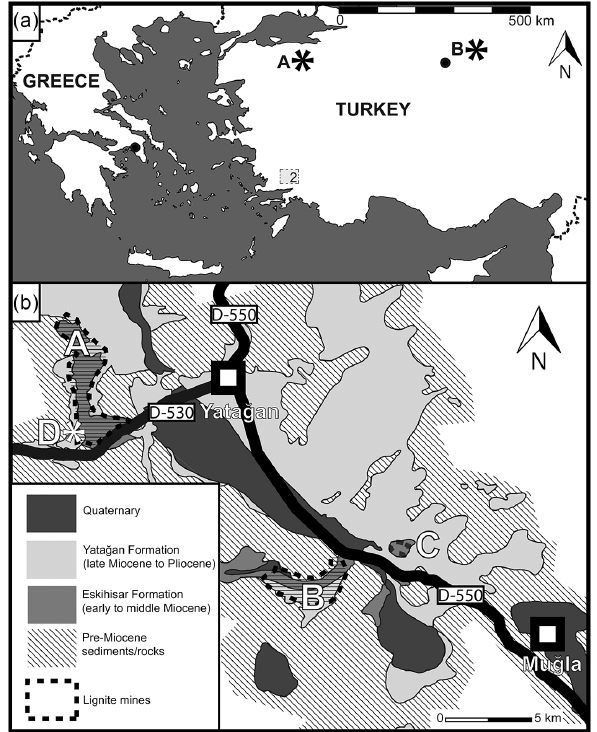
Figure 1. Geographic and regional geologic setting of the Yata˘gan Basin. (a) Map showing the geographical position of the Yata˘gan Basin (2) and the MN6 vertebrate fossil localities (*) Pa¸salar (A) and Çandir (B). (b) Simplified regional geological map of the Yata˘gan Basin based on Becker-Platen (1970) and Atalay (1980); lignite mines Eskihisar (A), Tınaz (B), Salihpa¸salar (C); vertebrate fossil locality (*) Yeni Eskihisar MN7/8